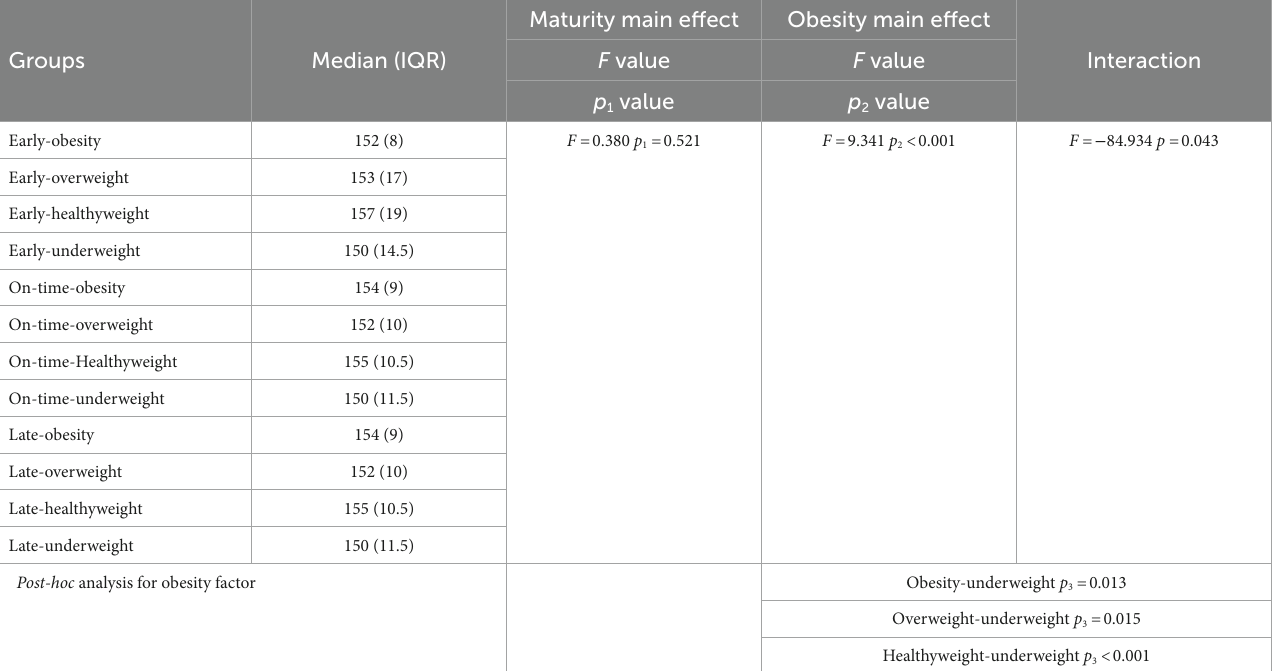
TABLE 3 Changes in the height of the participants according to the maturity and obesity groups.